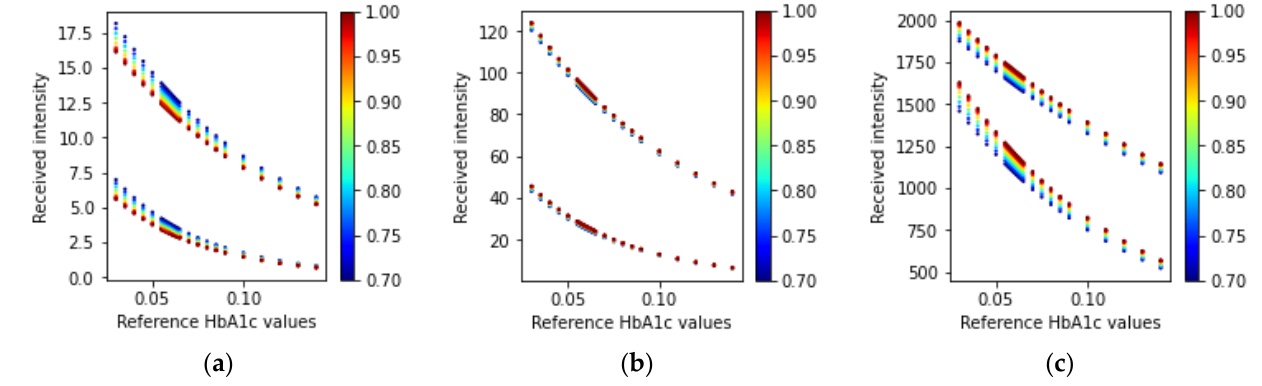
Figure 12. Received intensity values (fingertip: reflection-type) for the three wavelengths ( a ) 465 nm, ( b ) 525 nm, and ( c ) 615 nm. In each scatter plot, the top adjacent points correspond to the diastolic phase and the bottom points correspond to the systolic phase. The color bars at the side of the plots indicate the various SpO 2 values ranging from 70% to 100%.